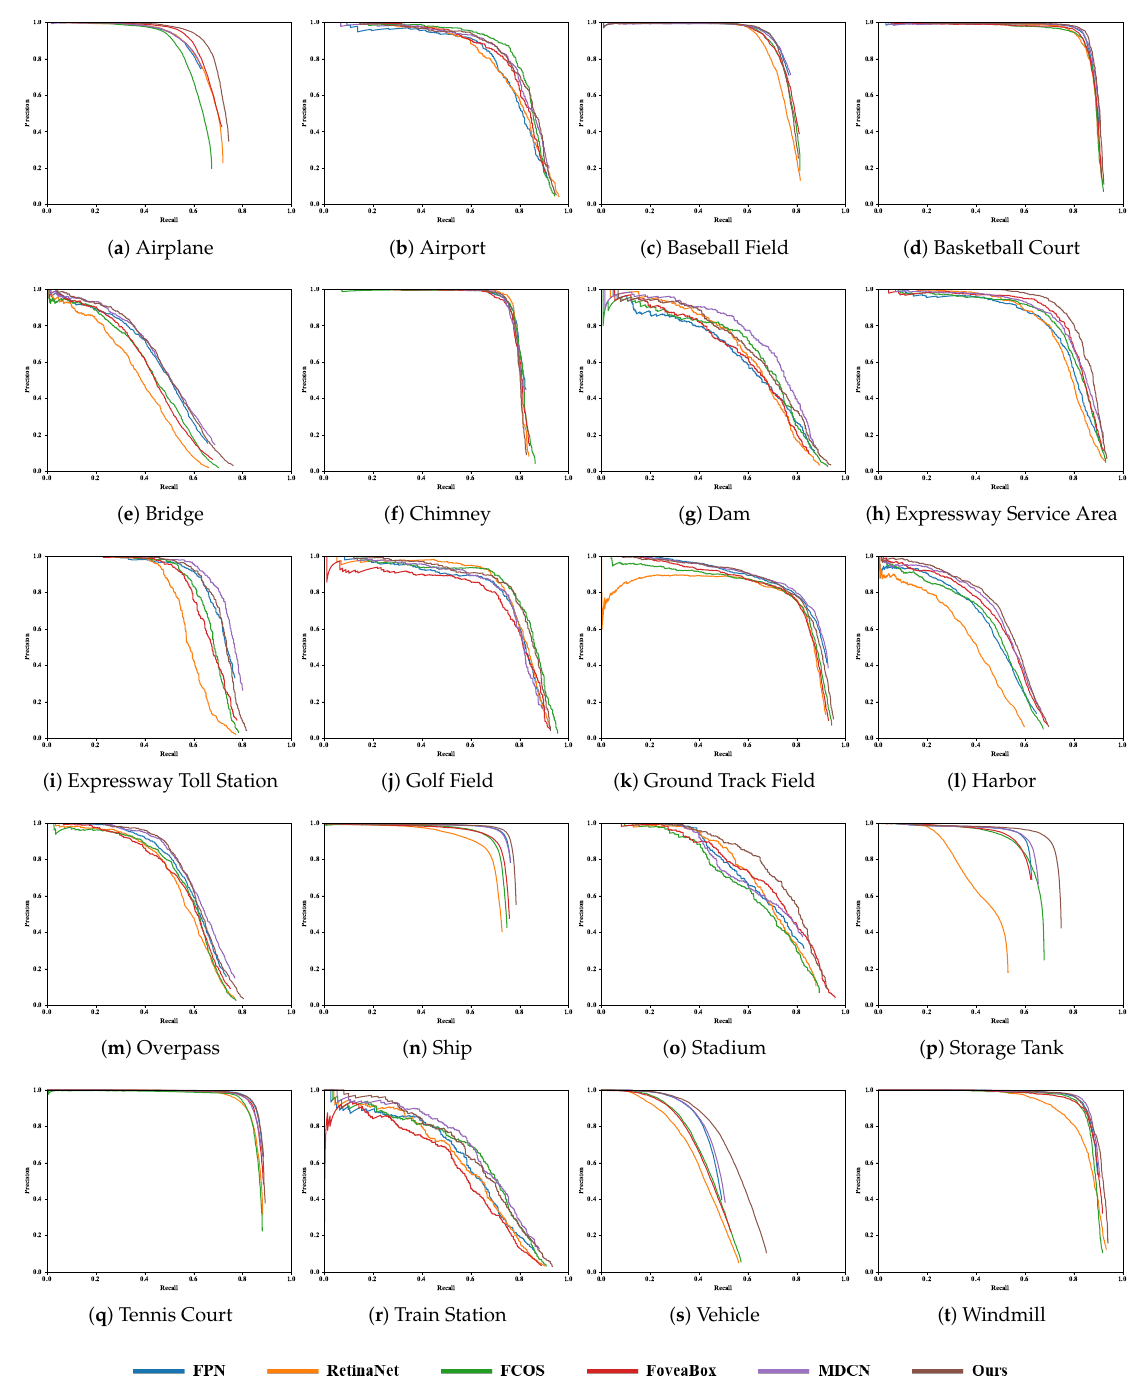
Figure 6. The precision-recall (PR) curves of different methods. Several samples of the detection results obtained by the proposed methods are shown in Figure 7. The green rectangles denote the predicted